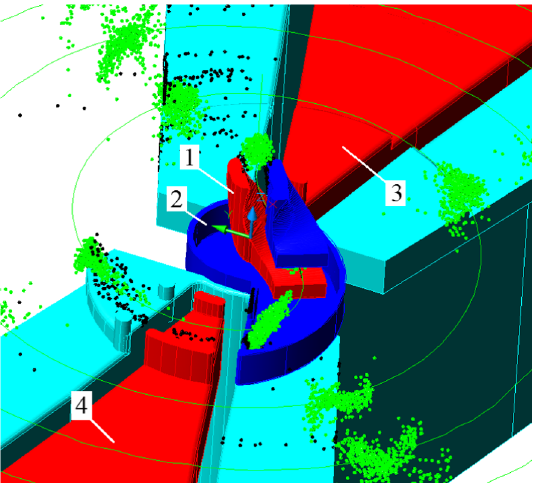
FIG. 7. AUTOCAD visualization of SNOP data in a cyclotron central region: 1 — spiral inflector, 2 — inflector rf shield, 3 — 1st dee, 4 — 2nd dee. Green dots indicate accelerated ions. Black dots are lost